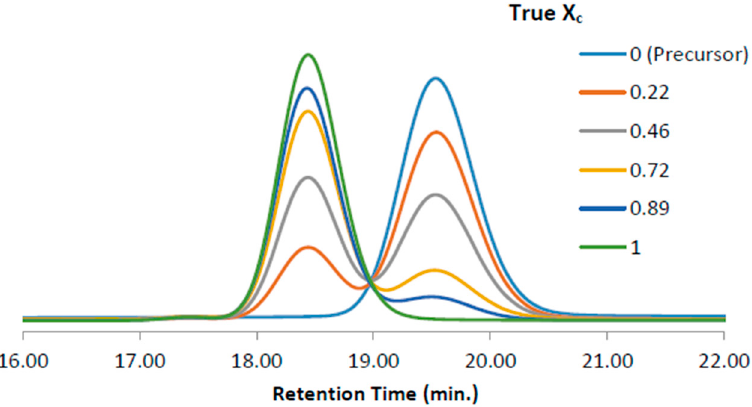
Figure 1. ( Top ) GPC traces of PSBr precursor (blue) and product of an ATRC reaction (red). ( Bottom )